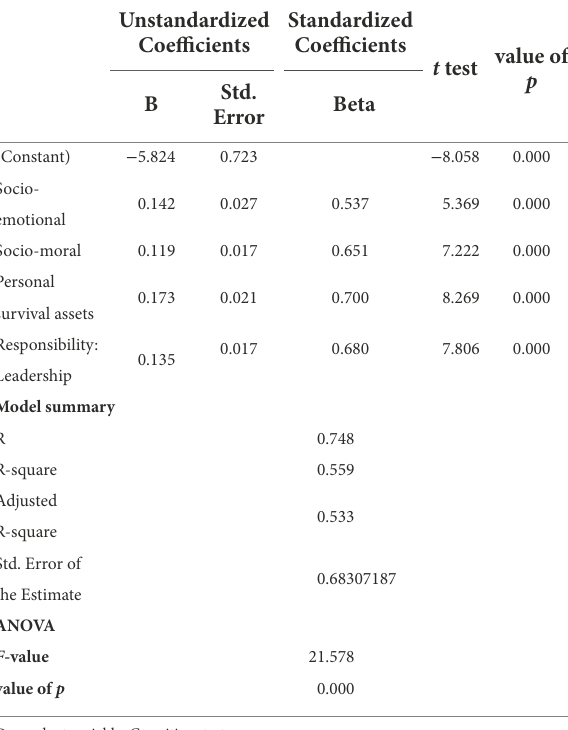
Unstandardized Coefficients